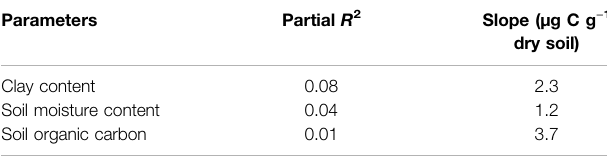
TABLE 3 | Multiple linear regression metrics for microbial respiration.